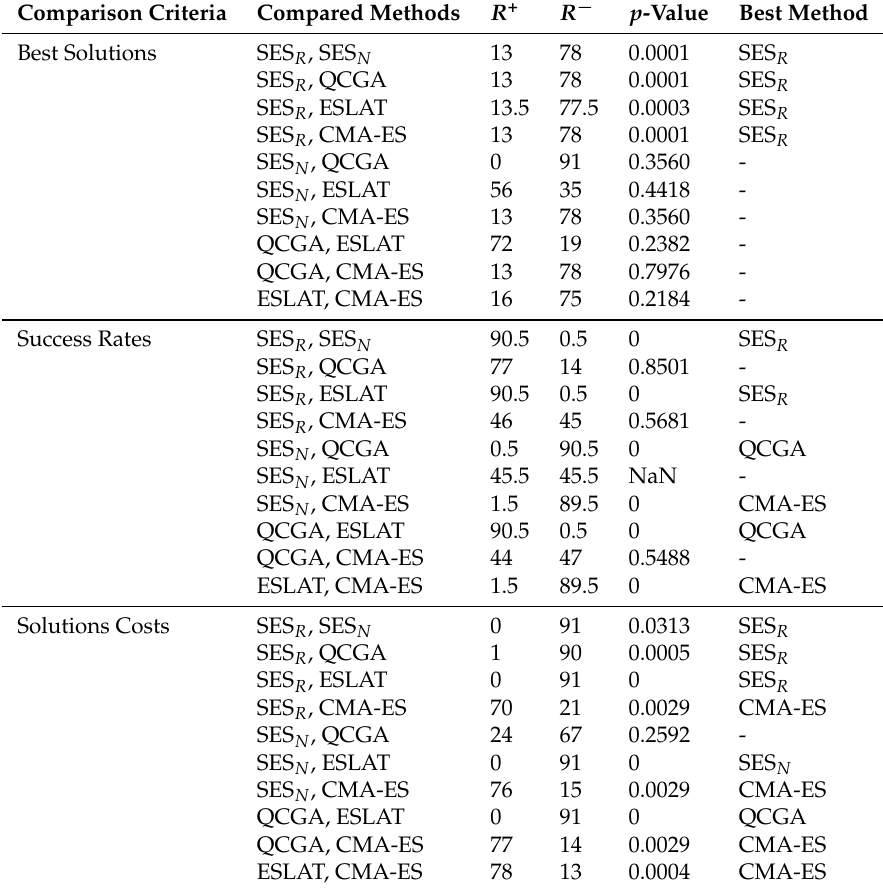
Table 6. Wilcoxon rank-sum test for the results of Tables 4 and